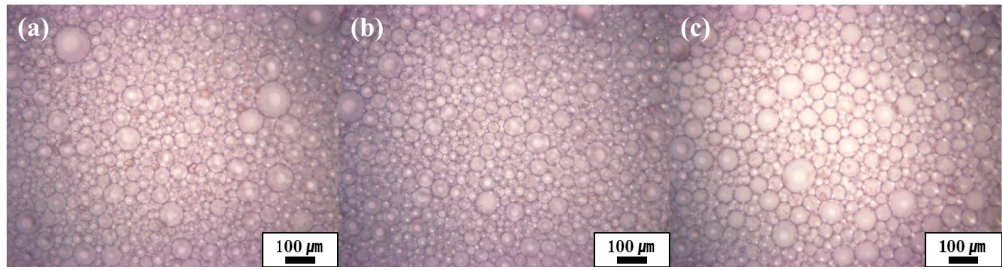
Figure 4. Optical micrographs of Pickering HIPEs prepared with 6 wt.% PAAS and 5 wt.% oligoimide particle concentrations with ( a ) 75 vol.% ( b ) 80 vol.%, and ( c ) 85 vol.% internal phase.